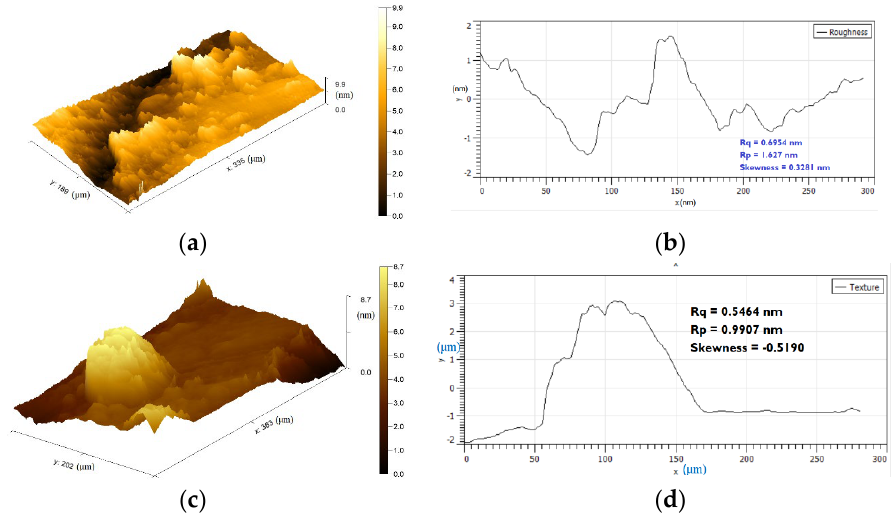
Figure 5. The AFM results of mild steel. ( a ) Uninhibited; ( b ) 2-D Height Plots of uninhibited; ( c ) Inhibited; ( d ) 2-D Height Plots of inhibited.